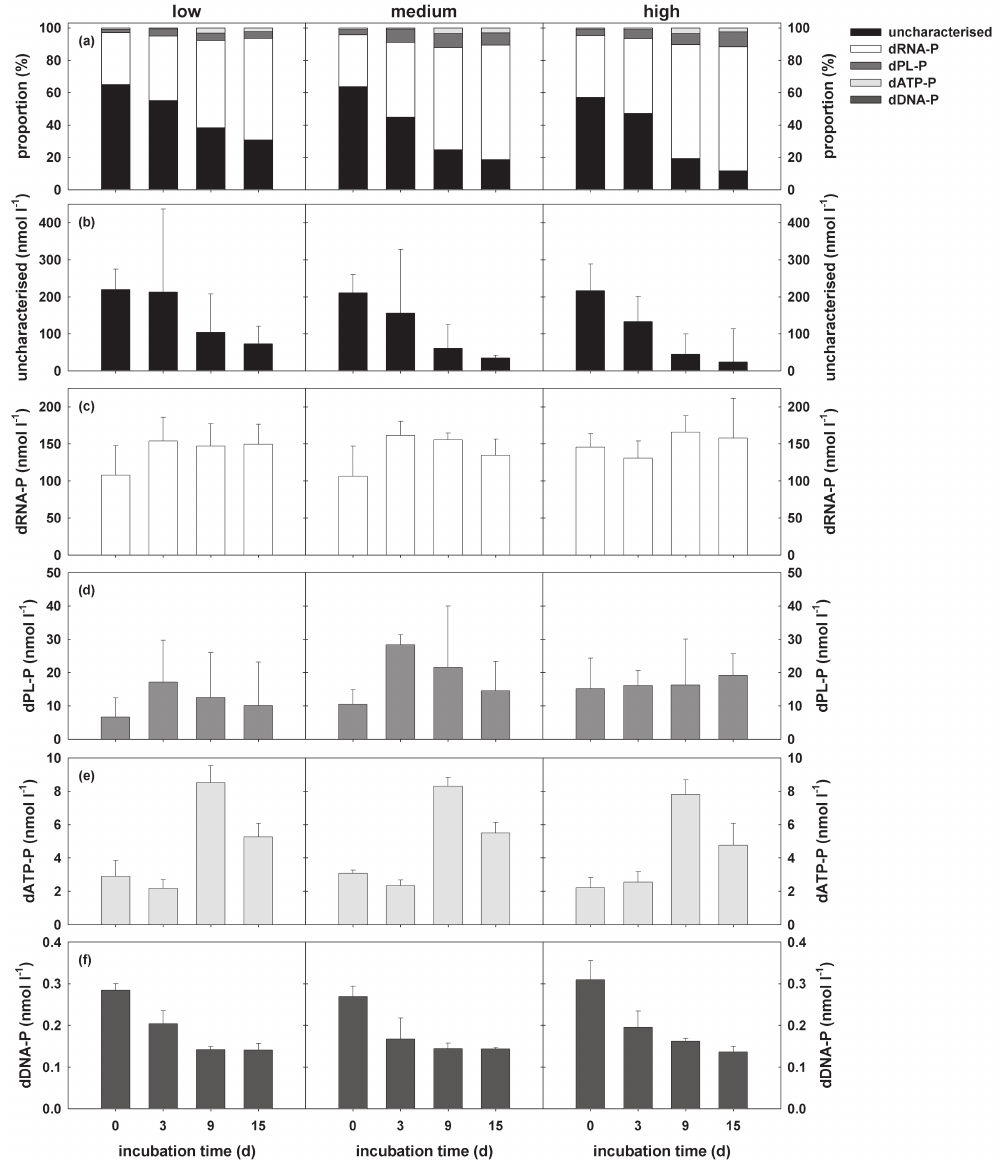
Fig. 4. Composition of DOP as %-proportion (a) ,and absolute values for the uncharacterised fraction, black (b) , dRNA-P, white (c) , dPL-P, mid-grey (d) , dATP-P, light-grey (e) , and dDNA-P, dark-grey (f) over incubation time and for the three p CO 2 treatments (low, medium, and